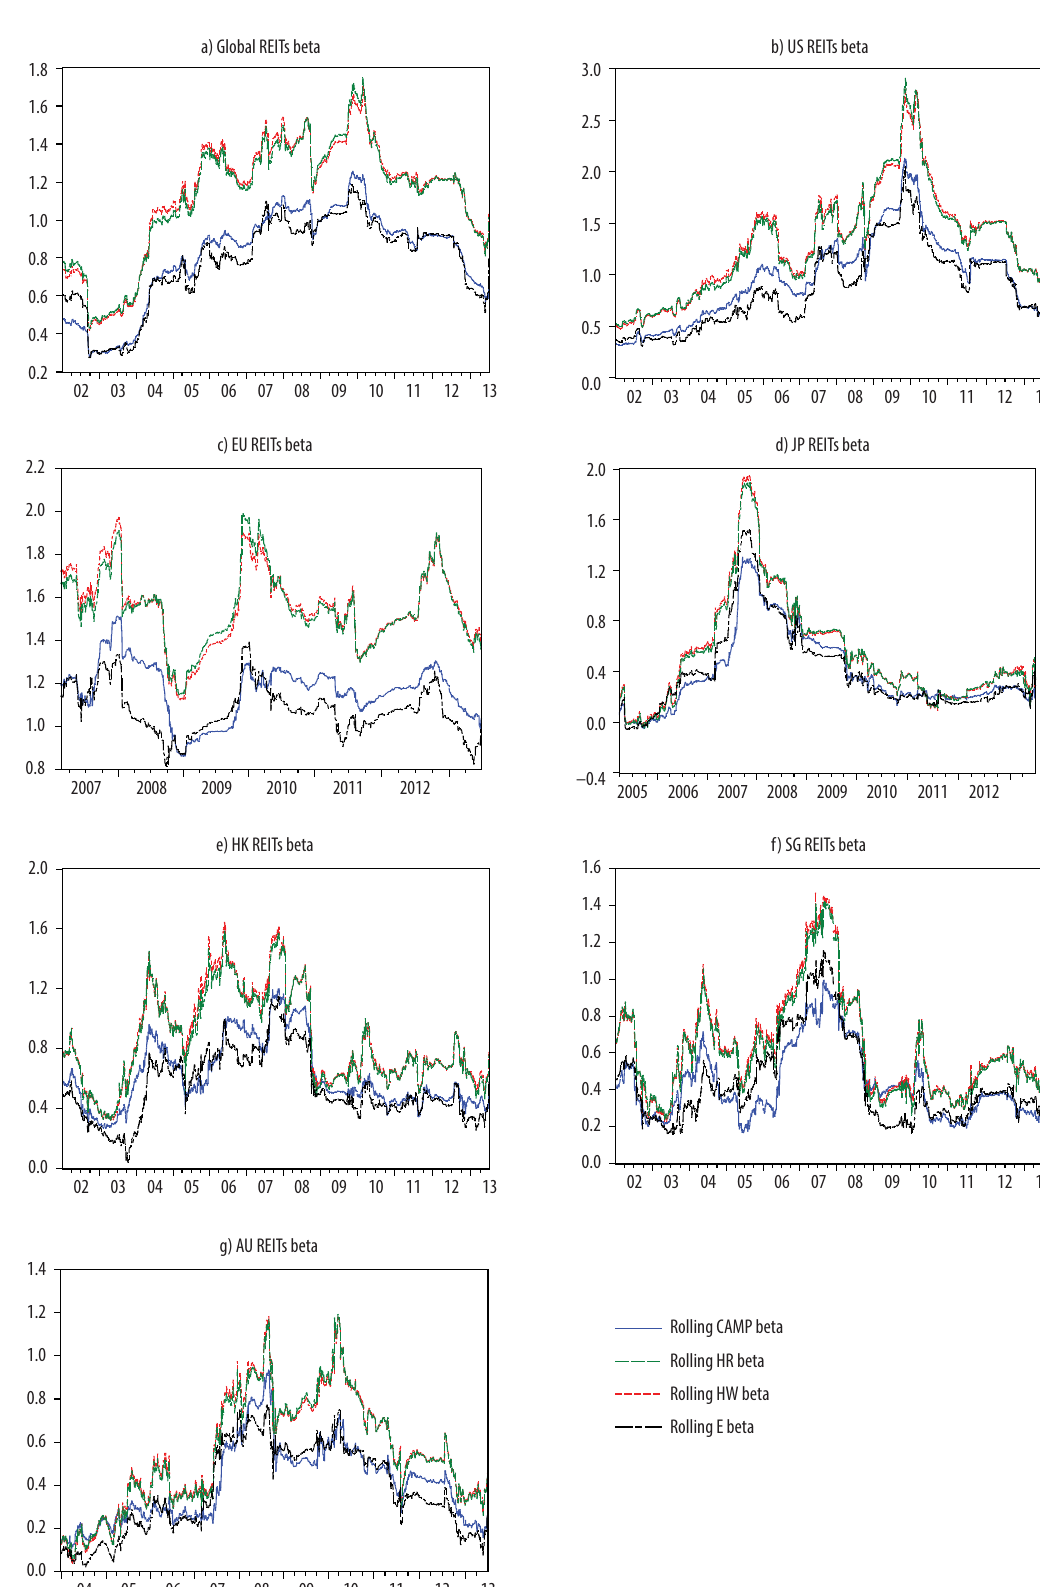
Fig. 3. The time-varying rolling CAPM beta and rolling downside